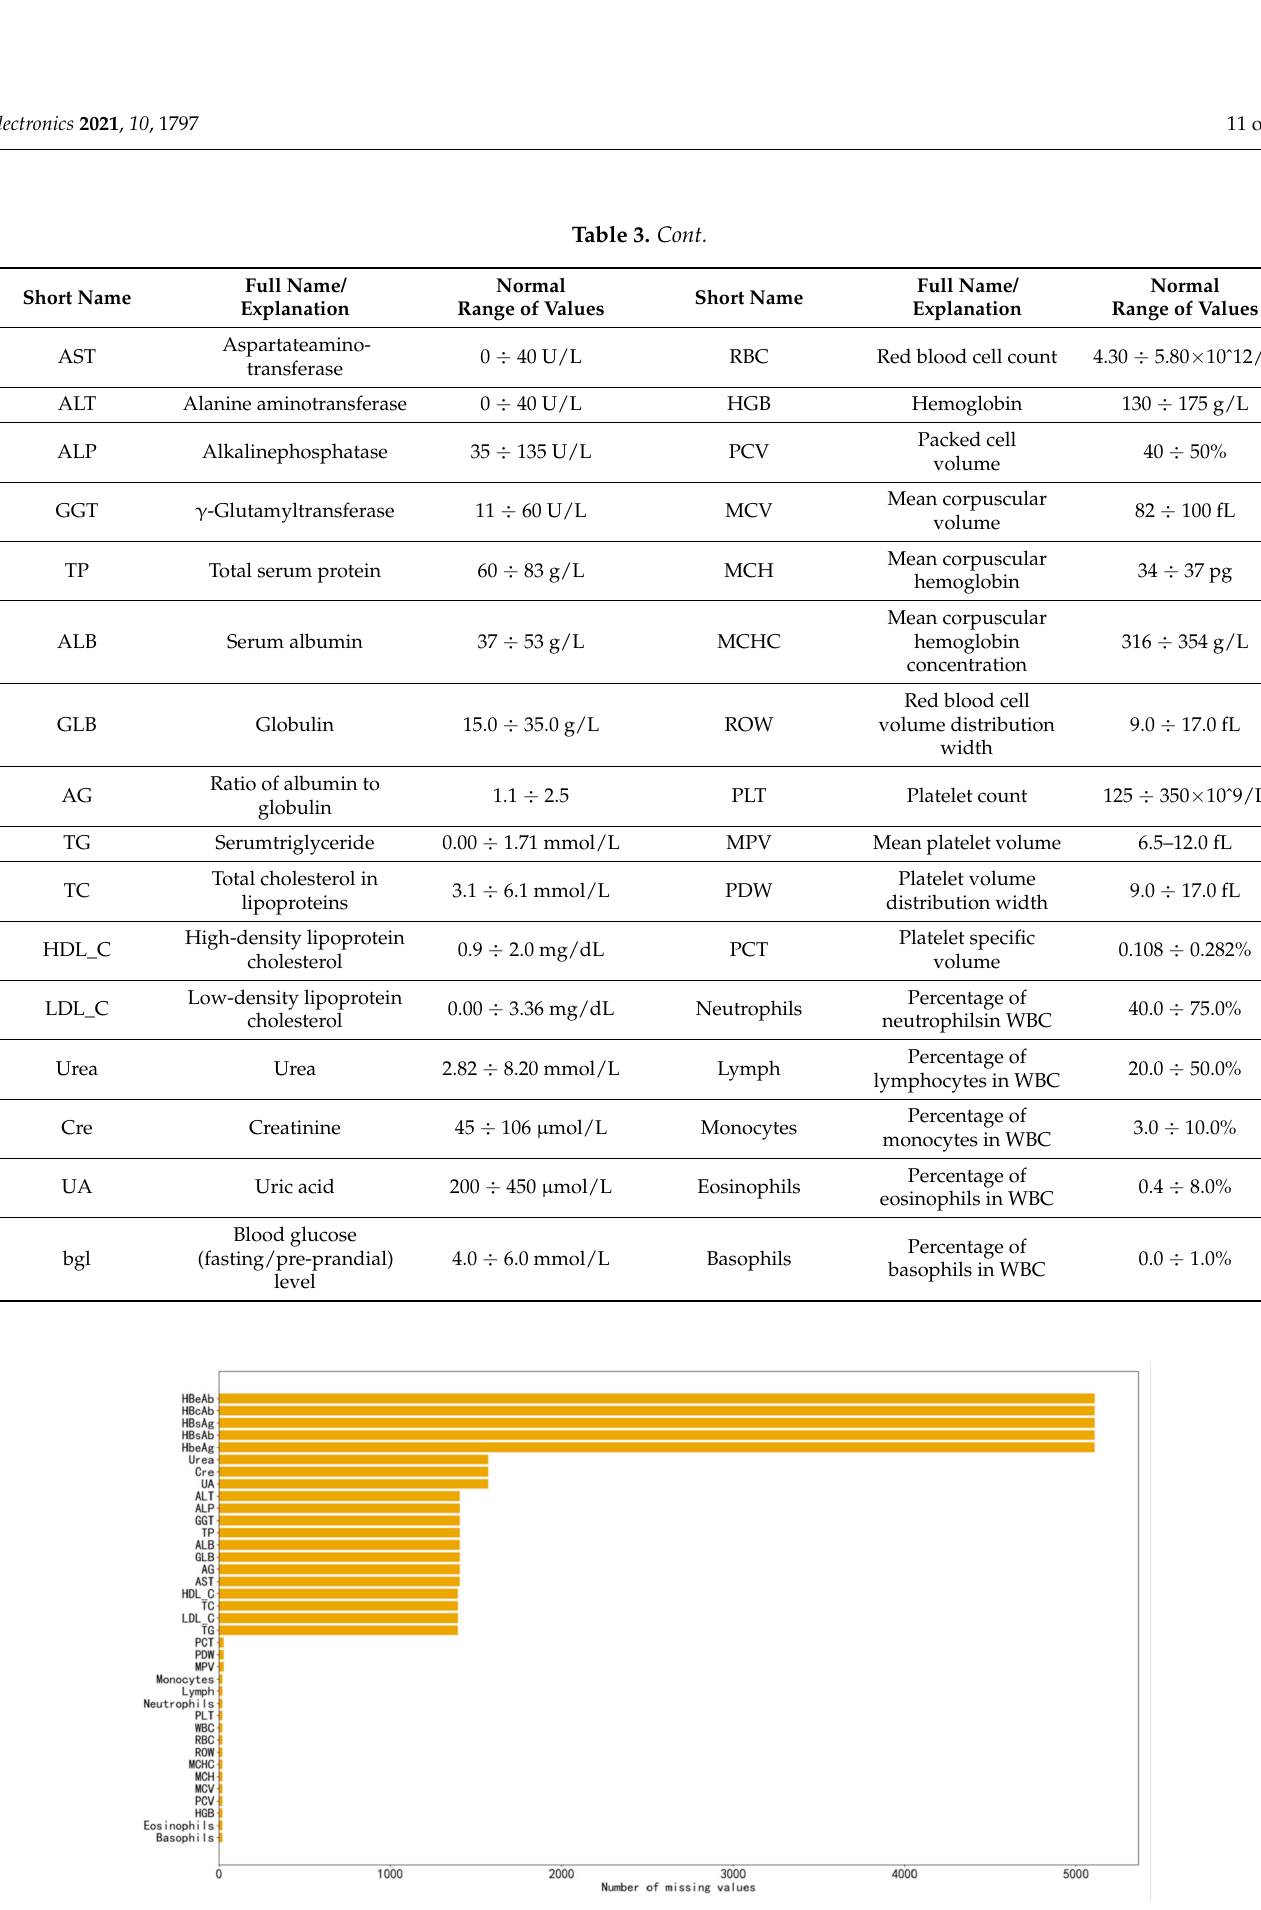
Figure 2. The number of missing values per data